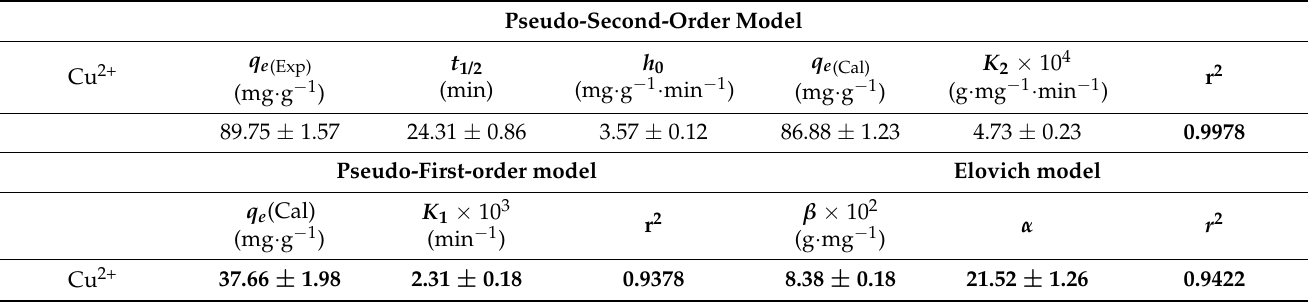
Table 2. Calculated kinetic model parameters for Cu (II) adsorption on MgY 2 O 4 @g-C 3 N 4 nanomaterials.